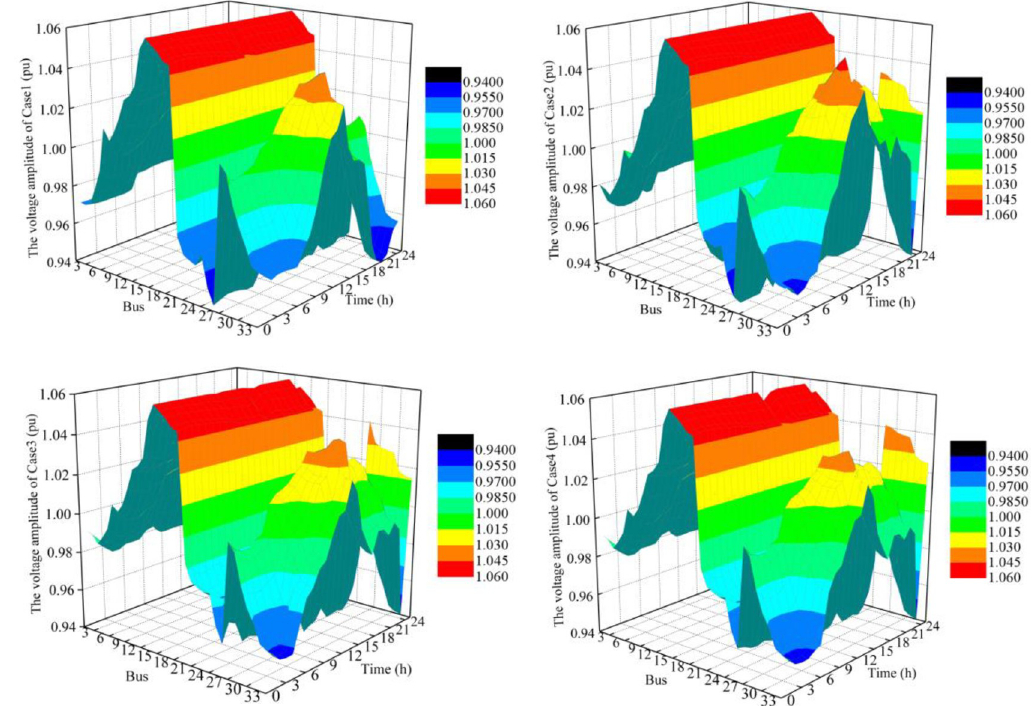
Fig 8. Voltage profiles in different cases.